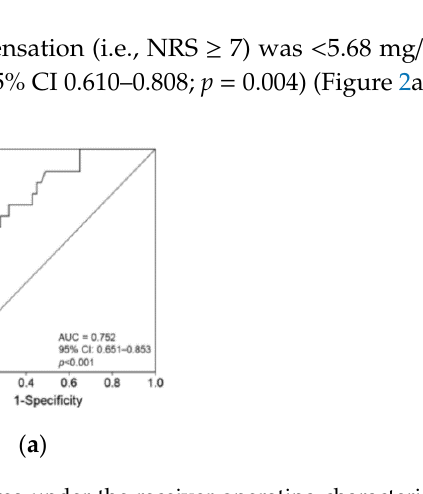
Figure 2. ( a ) The area under the receiver operating characteristic curve for vitamin C concentration associated with an increased incidence of moderate-to-severe symptoms of tingling, prickling or pins and needles sensation (i.e., NRS ≥ 4); ( b ) The area under the receiver operating characteristic curve for vitamin C concentration to predict severe tingling, prickling or pins and needles sensation (i.e., NRS ≥ 7).